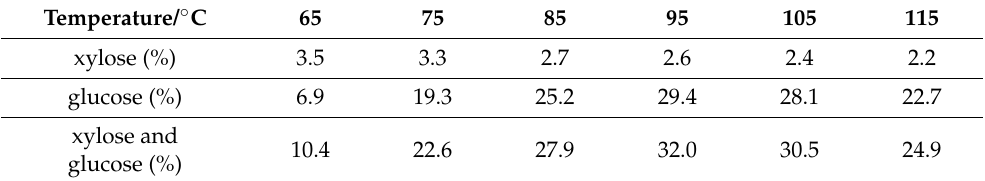
Table 3. Effect of temperature on xylose and glucose yield in the second step.